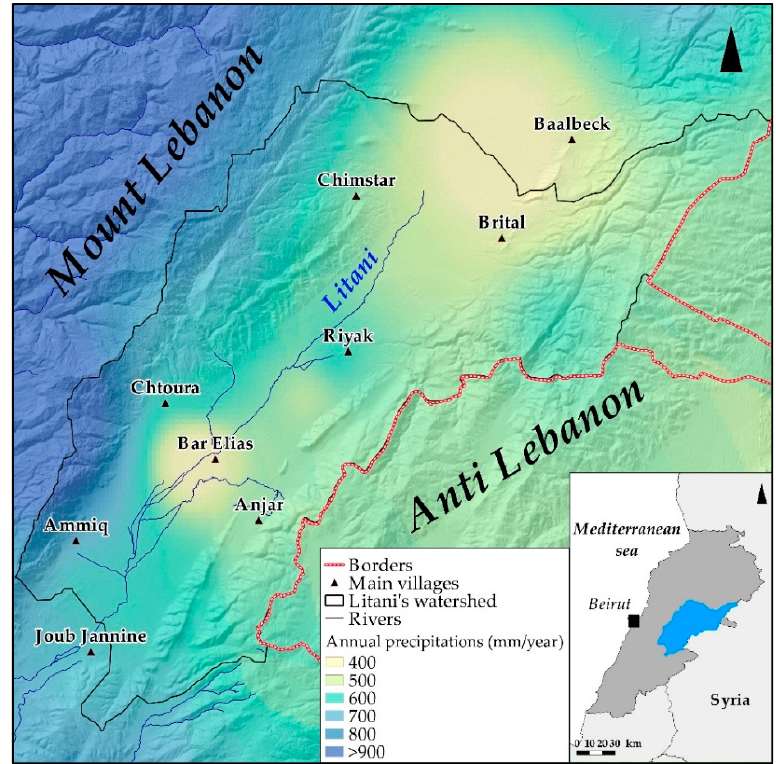
Figure 1. Annual precipitations of the study area, the Bekaa Valley [38].